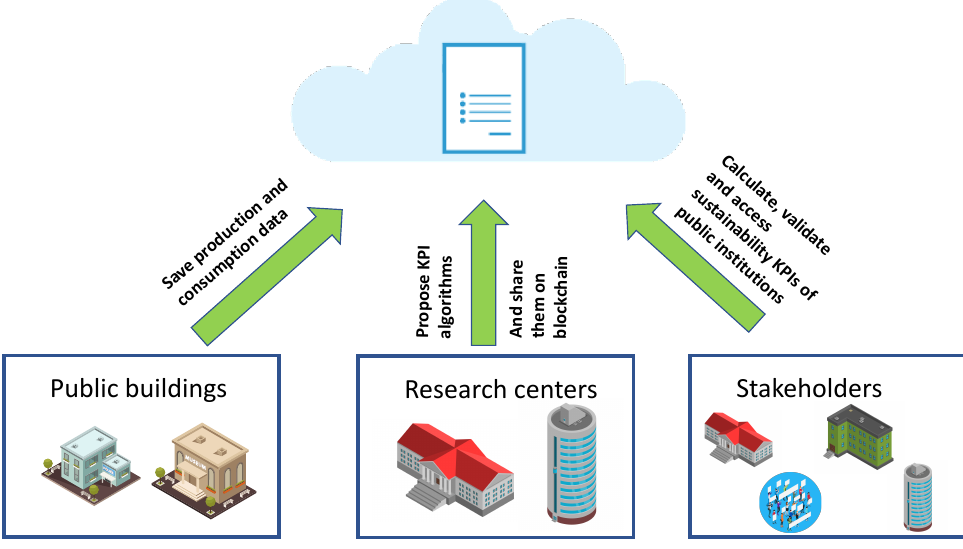
Figure 2. A schematic view of the proposed platform and